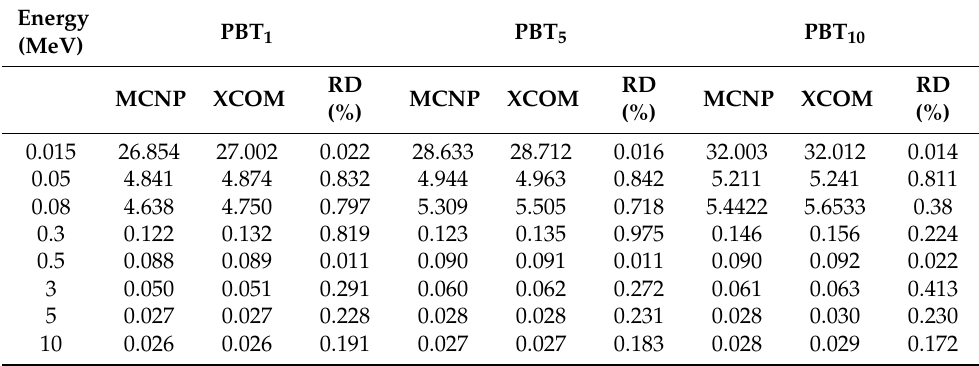
Table 3. Mass attenuation coefficients ( MAC ) (cm 2 /g) comparison of the MCNP and XCOM of the